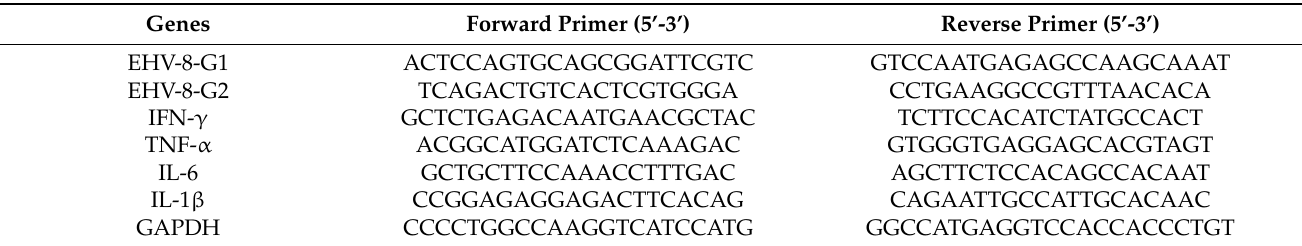
Table 1. Primers for EHV-8 detection or cytokines